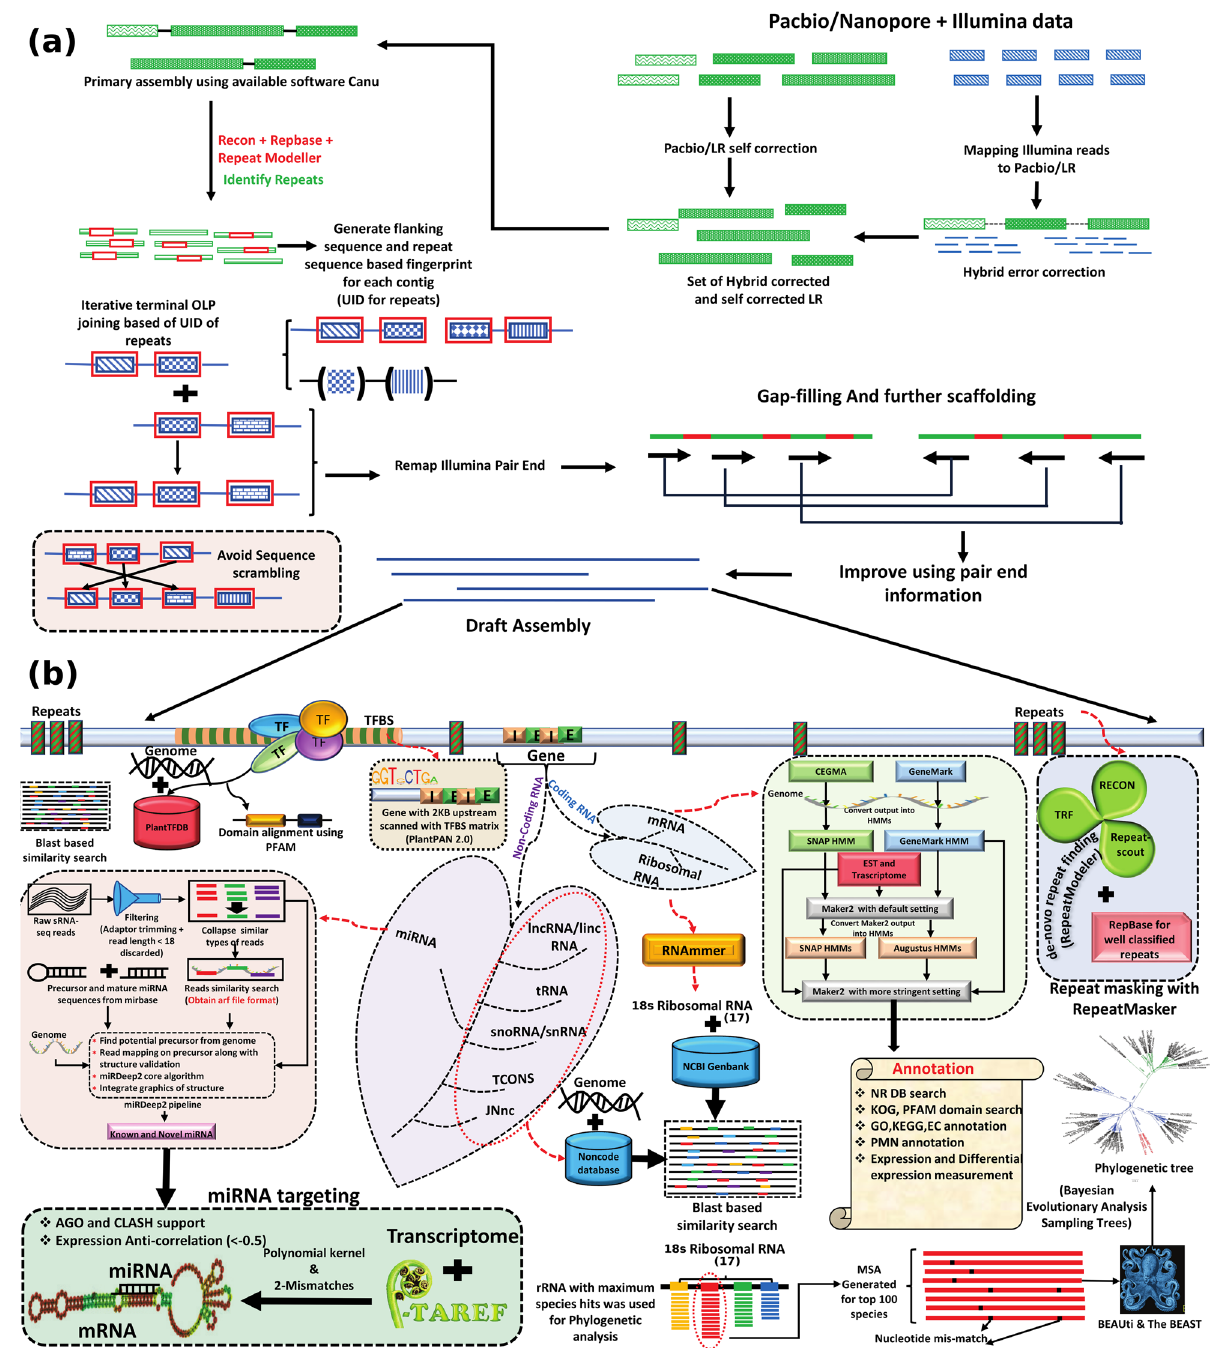
Figure 1. ( a ) Schematic diagram of the strategy used to join contigs into scaffolds using unique stretches of contigs. Initially PacBio long reads (LR) were corrected using self correction as well as by hybrid correction. LRs from both the strategies were used in Canu assembler for primary assembly. Primary assembly was checked for novel and known repetitive content. These contents were used to mask the assembly and generate unique tags. On the basis of unique regions and repeat families, unique identification (UID) was generated for each region. On the basis of these, UID scaffolds were generated with the help of local similarity search tool (BLAST). Further, this assembly was improved with Illumina PE read mapping. ( b ) Workflow of annotation pipeline followed for all the major components of the genome including repeats, transcription factors, genes, miRNAs, transcription factor binding sites (TFBS), phylogenetic analysis, miRNA targeting information and non-coding RNA annotation